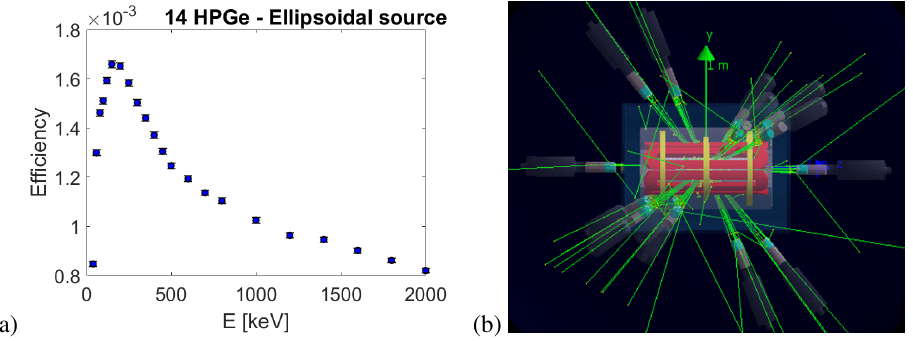
Figure 2. (a) E ffi ciency vs. γ -ray energy for the HPGe array. (b) Ray-tracing simulations for γ